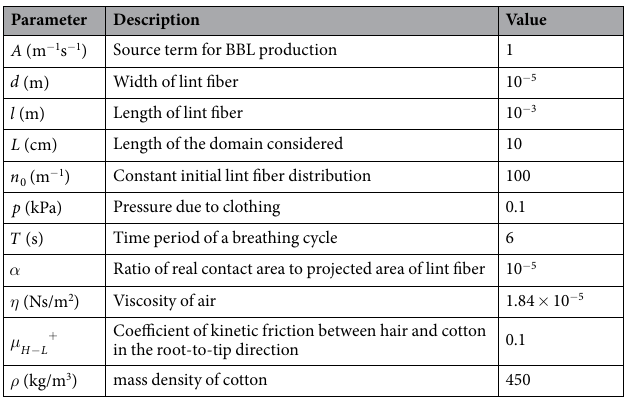
Table 1. Notation and values of parameters used in the